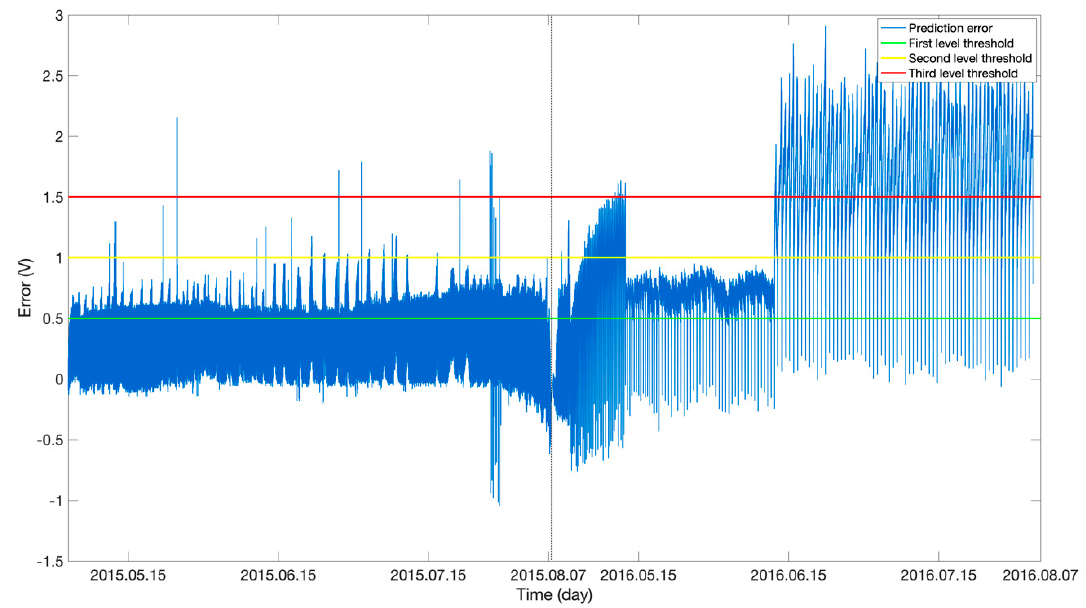
Figure 6. DBN-based comparison of the predicted and measured voltages.